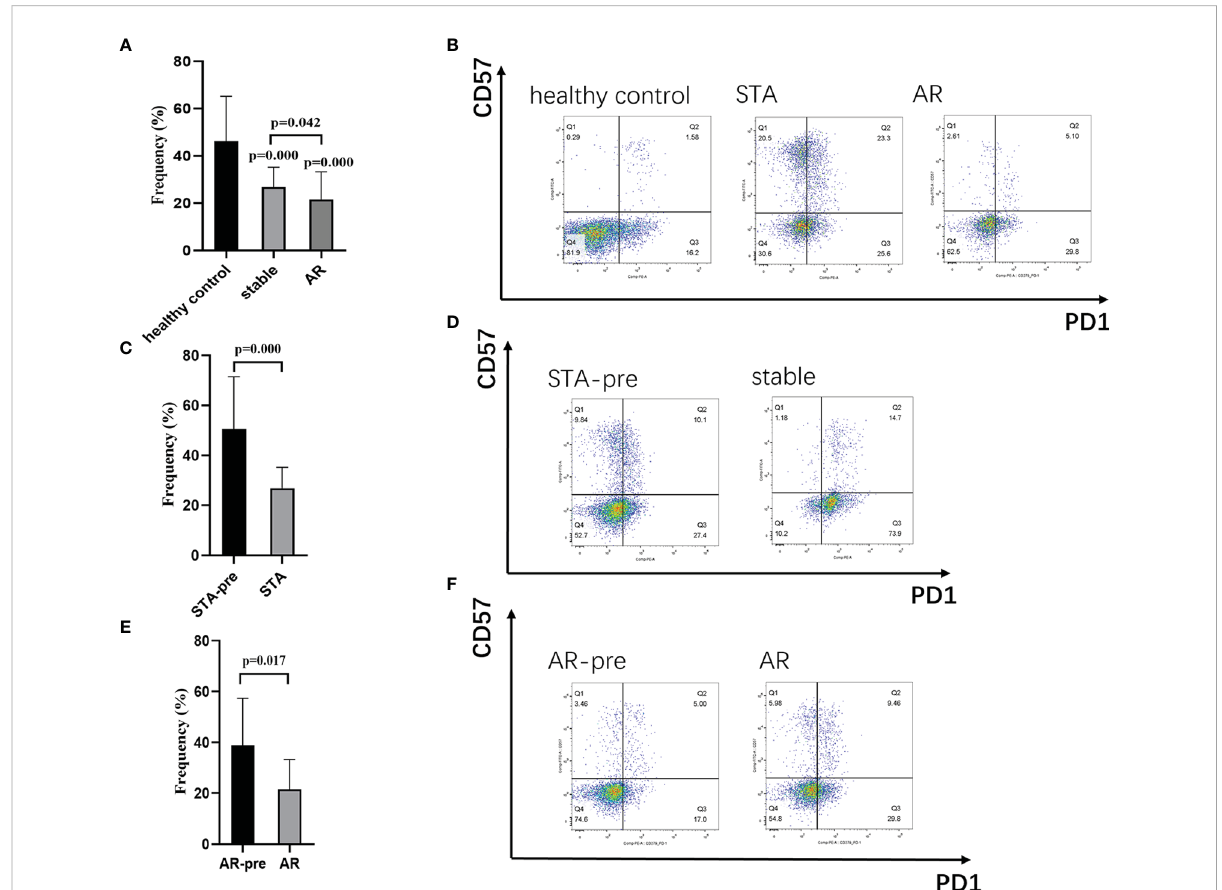
FIGURE 5 CD8+PD1+CD57- T cells in peripheral blood: (A) Recipients with acute rejection (AR) had signi fi cantly lower percentages of CD8+PD1+CD57- T cells compared with patients with stable renal function (STA) and the healthy control. (B) Representative histograms of CD8+PD1+CD57- T cell expression in the healthy control group, the STA group, and the AR group in fl ow cytometry. (C) Blood samples from the STA recipients had signi fi cantly higher percentages of CD8+PD1+CD57- T cells compared with preoperative blood samples from those that remain stable renal function within 1-year after transplantation (STA-pre). (D) Representative histograms of CD8+PD1+CD57- T cell expression in the STA-pre group and the STA group in fl ow cytometry. (E) Blood samples from recipients with AR had signi fi cantly higher percentages of CD8+PD1+CD57- T cells compared with preoperative blood samples from those occurred acute rejection within 1-year after transplantation (AR-pre). (F) Representative histograms of CD8+PD1+CD57- T cell expression in the AR-pre group and the AR group in fl ow